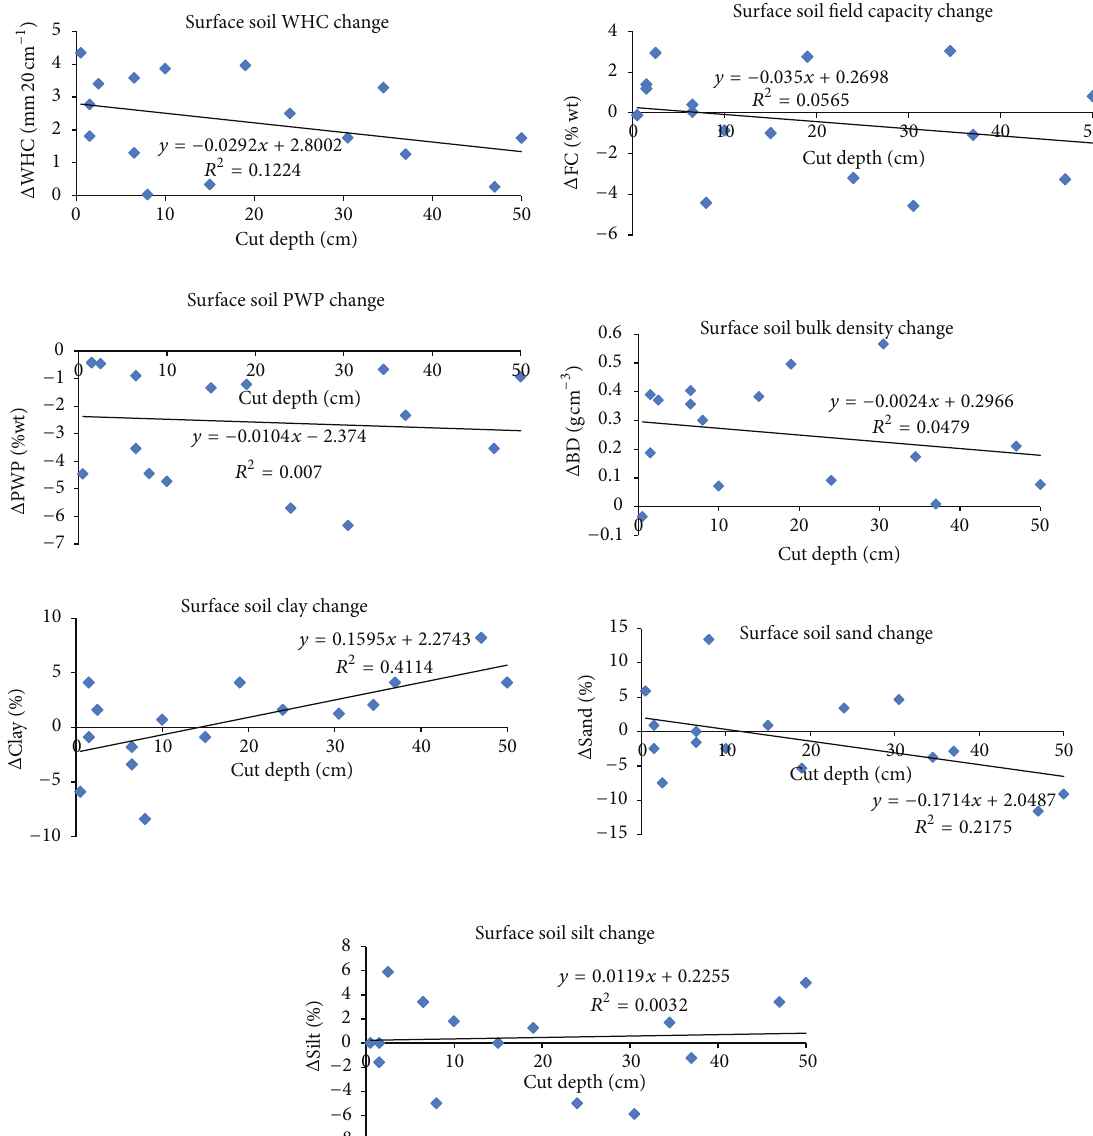
Figure 8: The relationships between the amounts of change of surface soil (0–20cm) physical properties that occurred as a result of leveling and cut depths through cut